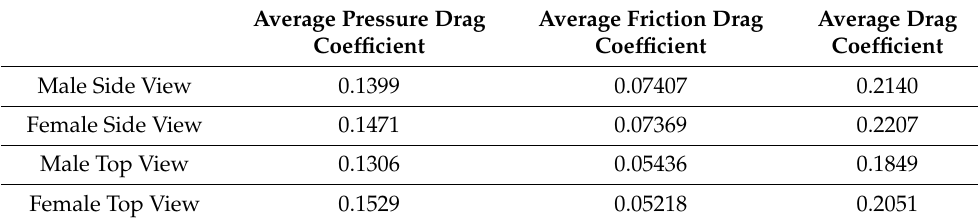
Table 3. Average Drag Coefficients of 2D Models.